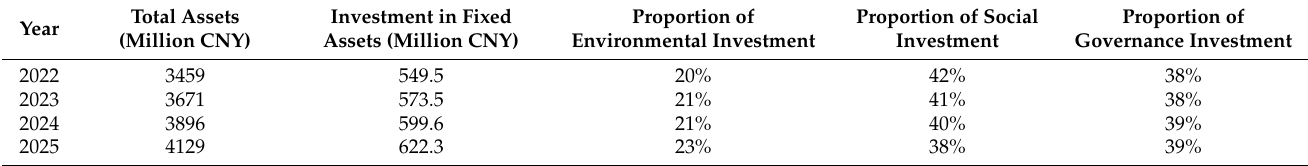
Table 6. 2022–2025 Selected provincial Power Grid Company Investment Scale Guidance.